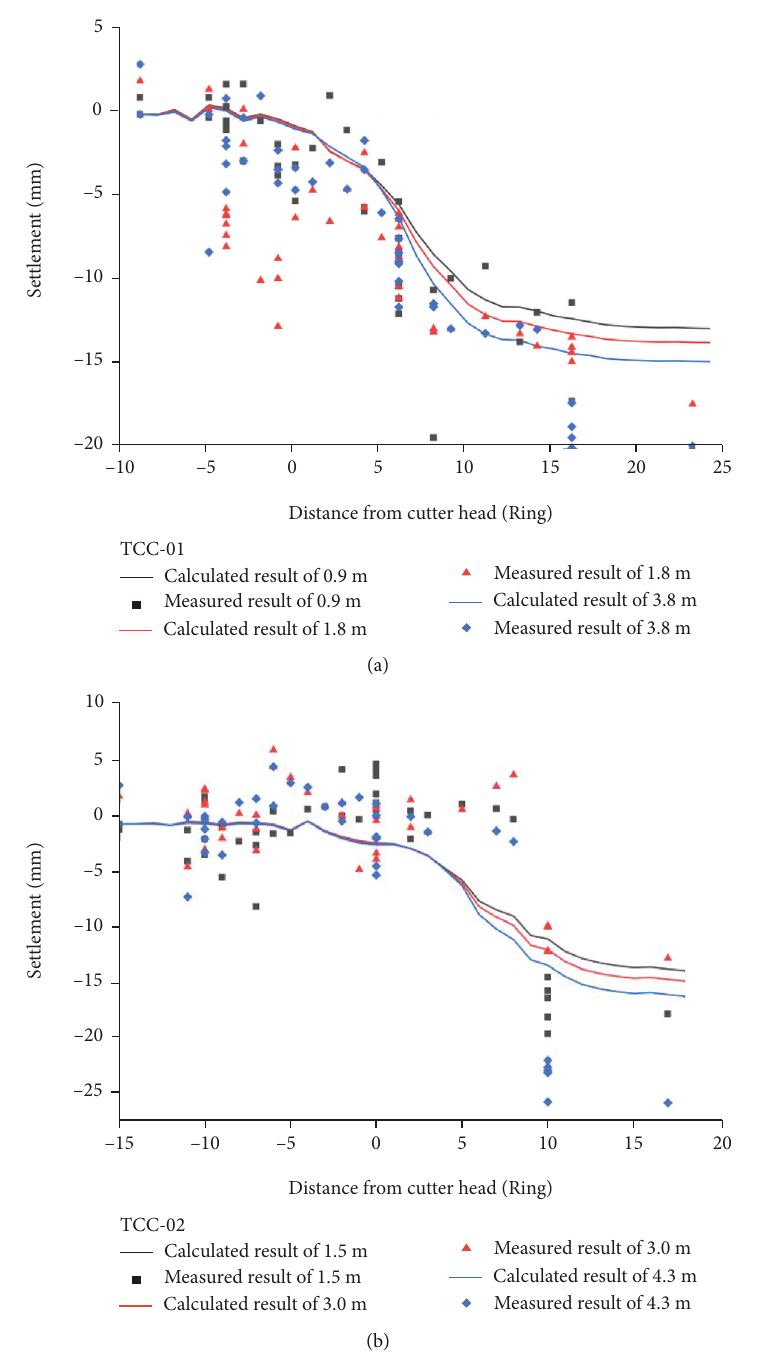
Figure 7: Settlement time history curve of soil layer above tunnel axis: (a) TCC-01 and (b)